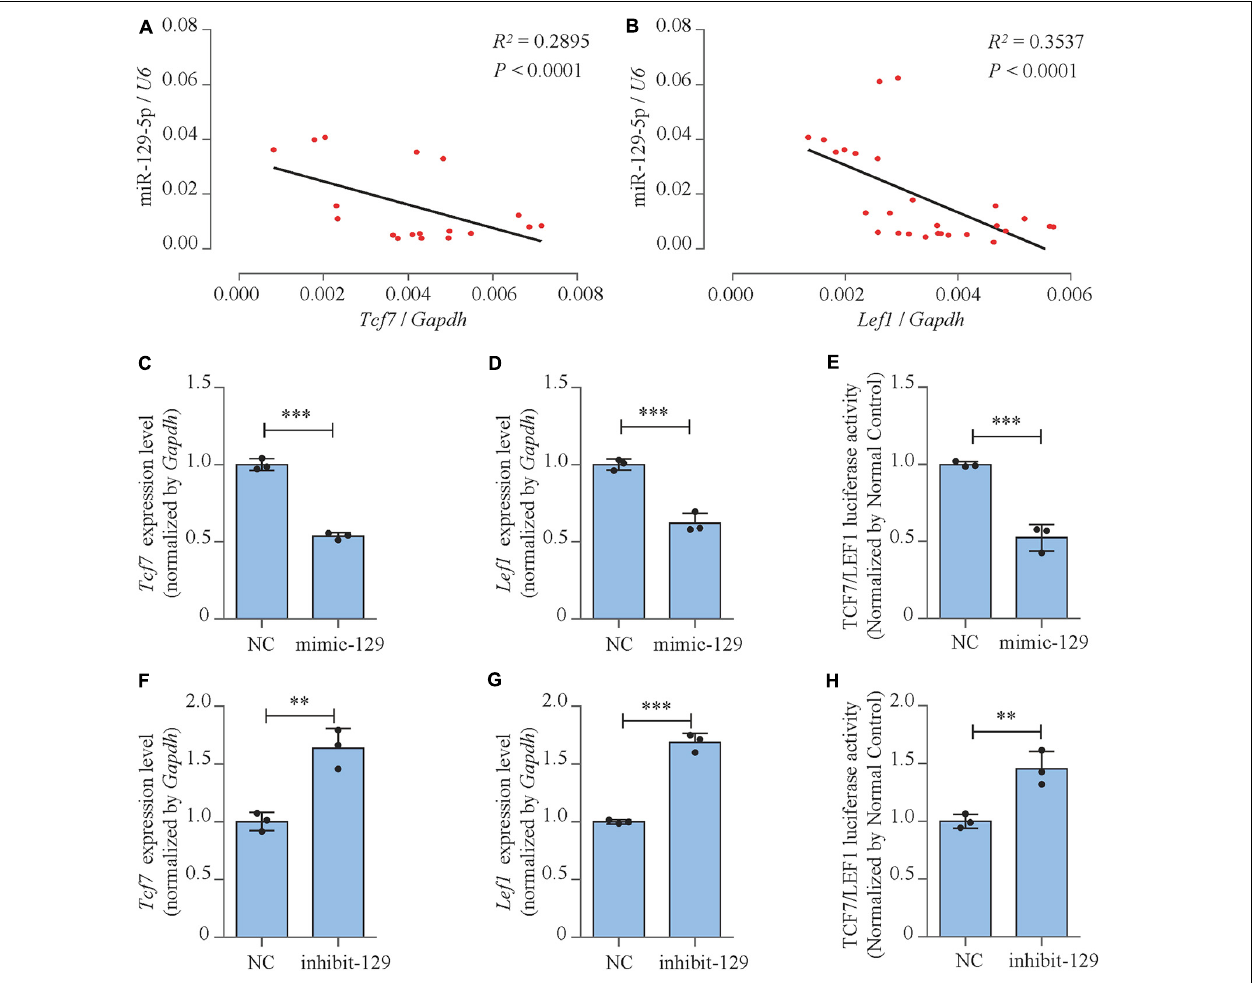
FIGURE 3 | miR-129-5p inhibited downstream transcript factors of Wnt/ β -catenin pathway. (A,B) Correlation analysis between miR-129-5p and Tcf7 or Lef1 mRNA levels in femur tissues from C57BL/6 mice, respectively, as detected by reverse transcriptase-polymerase chain reaction (RT-PCR). (C,D) Tcf7 and Lef1 expression levels of MC3T3-E1 cells treated with mimic-129-5p, as detected by RT-PCR (mean ± SD, ∗∗∗ P < 0.001). NC, mimic-NC; mimic-129, mimic-129-5p. (E) TCF7/LEF1 activities of MC3T3-E1 cells treated with mimic-129-5p, as detected by luciferase reporter assay (mean ± SD, ∗∗∗ P < 0.001). (F,G) Tcf7 and Lef1 expression levels of MC3T3-E1 cells treated with inhibitor-129-5p, as detected by RT-PCR (mean ± SD, ∗∗ P < 0.01, ∗∗∗ P < 0.001). NC, inhibitor-NC; inhibit-129, inhibitor-129-5p. (H) TCF7/LEF1 activities of MC3T3-E1 cells treated with inhibitor-129-5p, as detected by luciferase reporter assay (mean ± SD, ∗∗ P < 0.01).